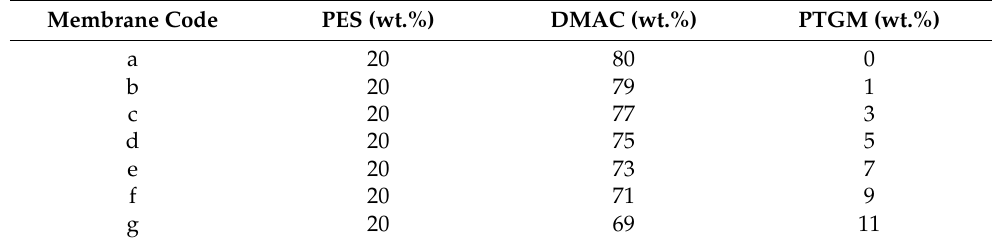
Table 1. Composition of the prepared casting solutions of PES/PTGM membranes. Membrane Code PES